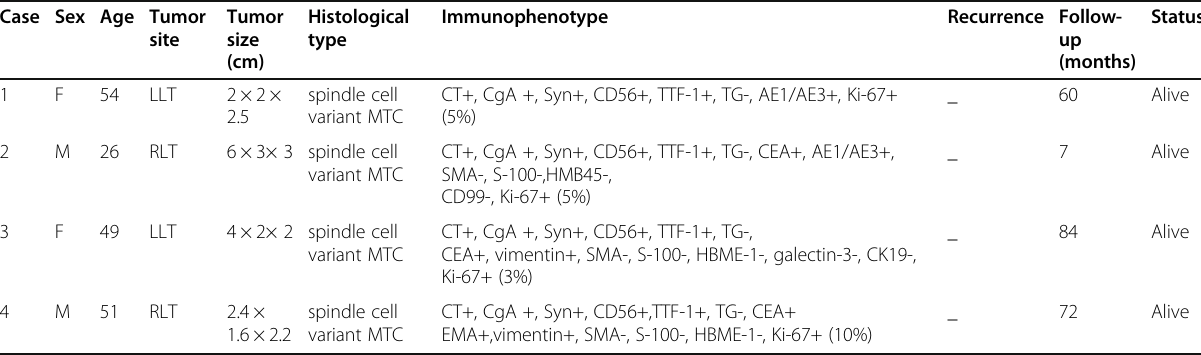
Table 1 Clinicopathological variables of patients with spindle cell variant of medullary thyroid carcinoma Case Sex Age Tumor